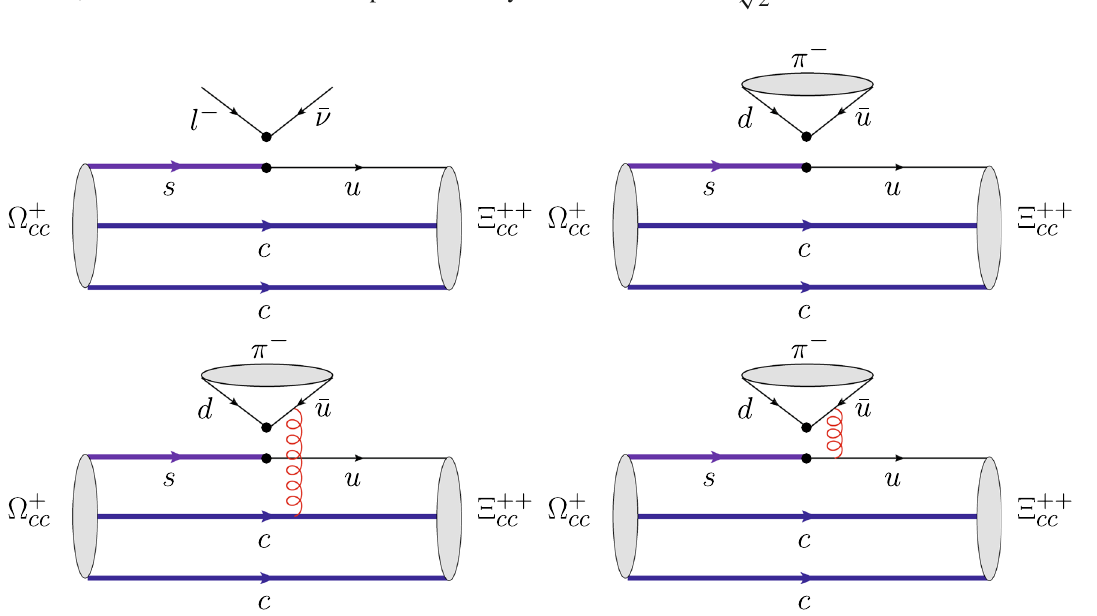
Fig. 1 Feynman diagrams for semileptonic and nonleptonic decays of doubly heavy decay baryons. The upper two panels show the leading- order Feynman diagrams, while the lower two panels denote the non-